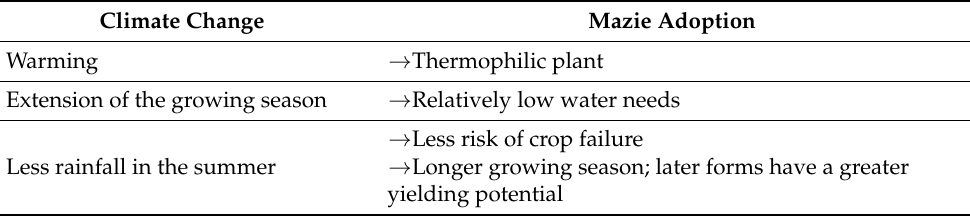
Table 2. Maize adaptation and response to an anticipated climate change. Climate Change Mazie Adoption